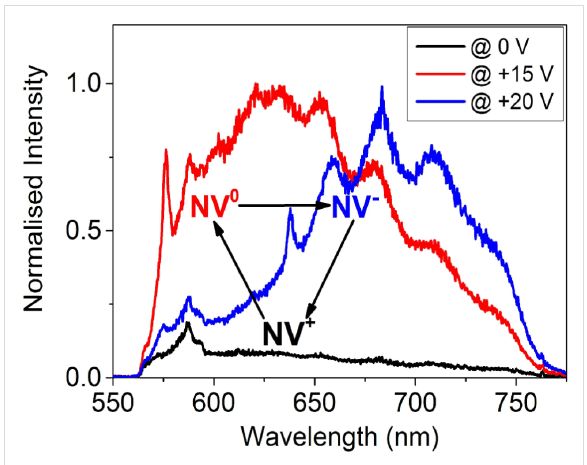
Figure 2a. The current–voltage characteristic of this diode, measured at ambient conditions, shows very good Schottky properties (Figure 2b).